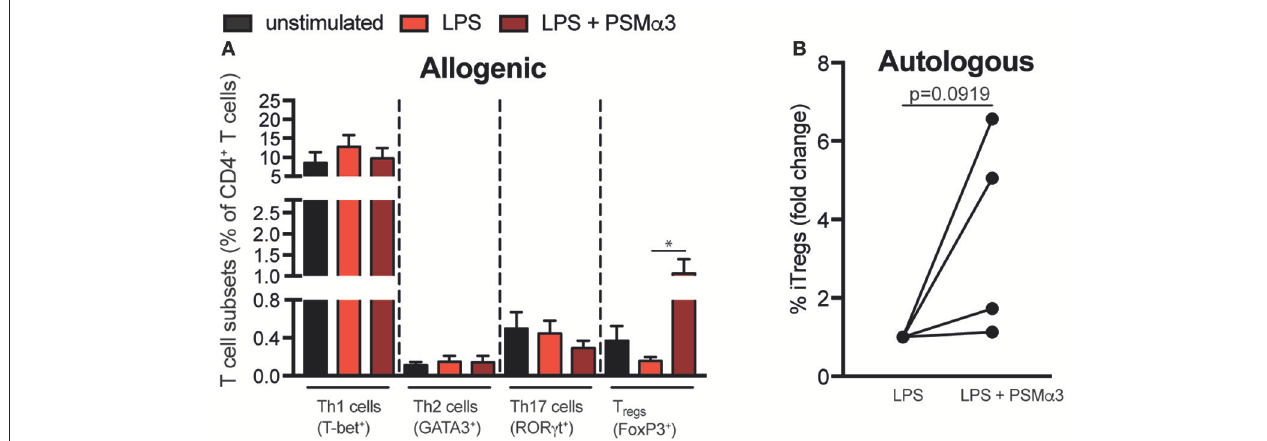
FIGURE 7 | PSM α 3-treated moDCs induce T regs from CD4 + T cells of patients with autoimmune diseases. (A) Allogenic T-cell assay: MoDCs from healthy donors were treated for 24h with LPS with or without PSM α 3 and co-cultured with CFSE-labeled CD4 + T cells from patients with Th17-associated spondyloarthritis for 3 d or 4 d. The different T cell subsets were analyzed by flow cytometry. The graph shows the frequency of the T-bet + Th1, GATA3 + Th2, ROR γ t + Th17 cells and CD127 − CD25 hi CD45RA − Foxp3 hi iT regs from CD4 + T cells ( n = 6 patients; mean ± SEM). * p < 0.05, one-way ANOVA with Turkey’s posttest or Kruskal-Wallis with Dunn’s posttest. (B) Autologous T-cell assay: MoDCs from spondyloarthritis patients were treated as described in (A) and co-cultured with CFSE-labeled CD4 + T cells from the same patient. CD127 − CD25 hi CD45RA − Foxp3 hi iT regs were analyzed by flow cytometry. The graph shows the frequency of iT regs as fold change from LPS-treated cells of 4 different spondyloarthritis patients. Data were analyzed by unpaired student’s T